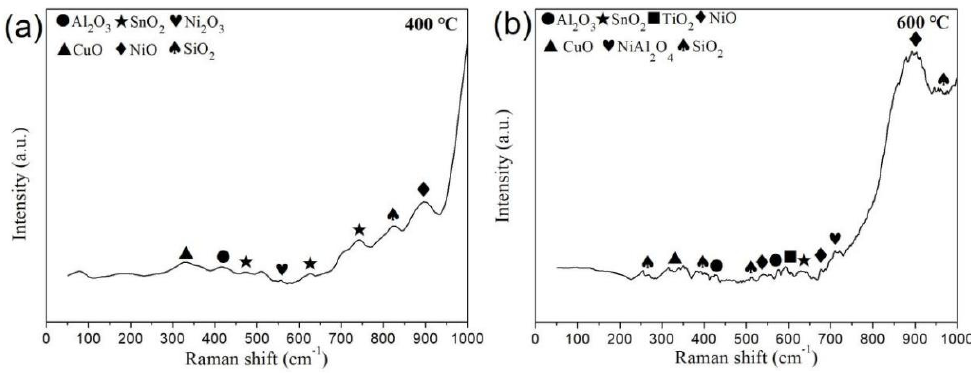
Figure 12. Raman spectra of the worn surfaces of NST at 400 ( a ) and 600 °C ( b ).